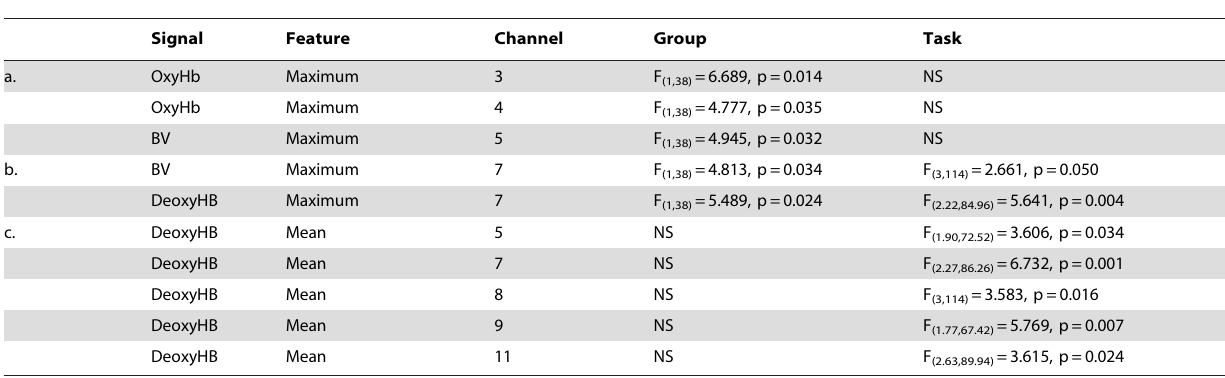
Table 2. Significant fNIR-feature based ANOVA results.